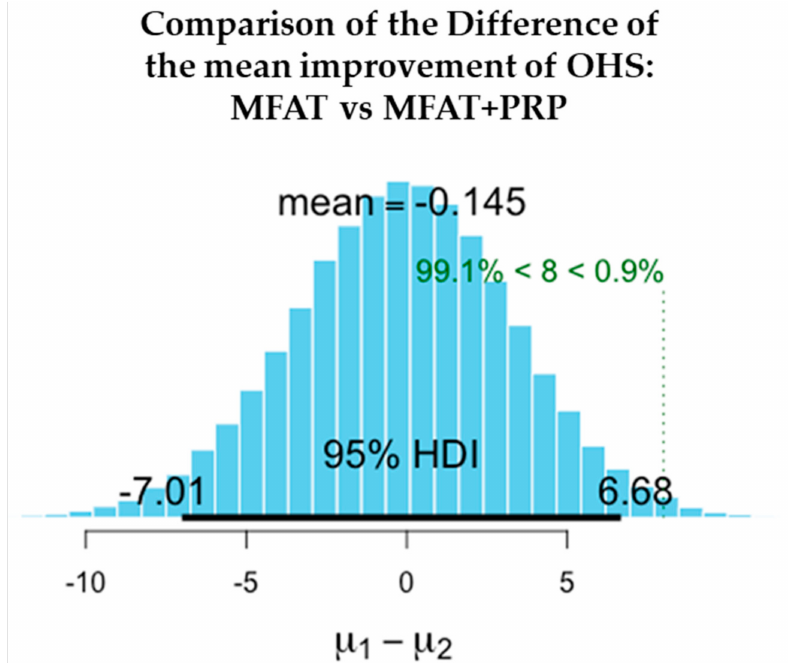
Figure 11. This demonstrates the difference between the change in OHS in MFAT only and MFAT + PRP treatments. ( µ 1 ) The difference in OHS following treatment by MFAT only (OHS at one year–Index OHS); ( µ 2 ) the difference in OHS following treatment by MFAT + PRP (OHS at one year–Index